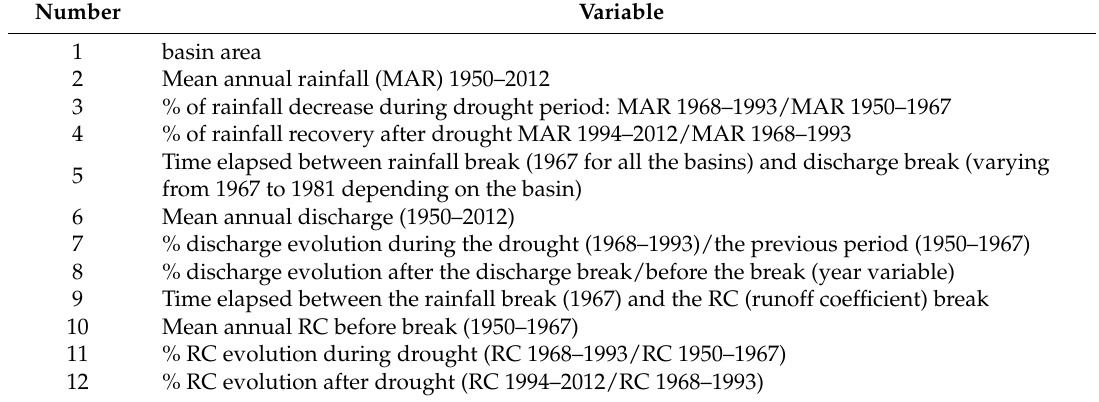
Table 2. List of the variables used in the PCA analysis of the factors explaining the hydrological functioning of West African